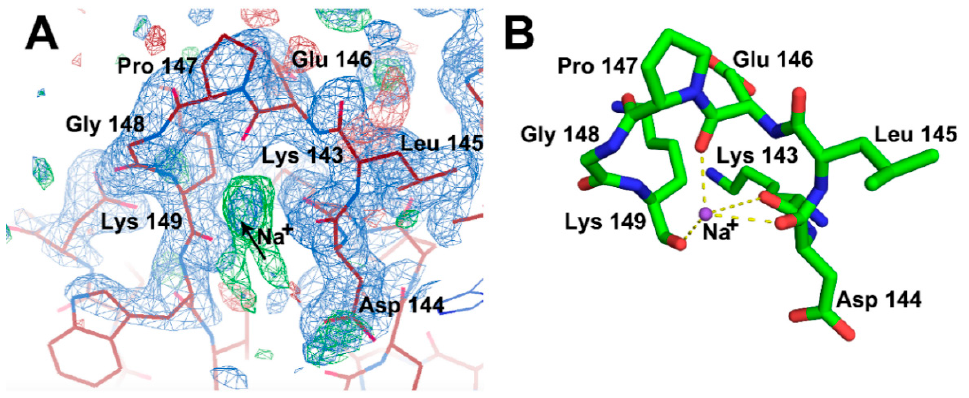
Figure 5. Na + was identified in crystal Structure 1 of AbPPase. The 2| F o |–| Fc |, α c map contoured at 1 δ is shown as blue density. The | F o |–| Fc |, difference density map contoured at 3 δ is shown as green density. ( A ) The electron density map of Na + molecule in Structure 1 of AbPPase. Black arrow indicates where the Na + molecule is located. ( B ) The coordination of Na + molecule by a loop in Structure 1 of AbPPase. Lys143 and Lys149 make coordination with Na + through their β -ketone groups. Pro147 forms the turn for this loop.